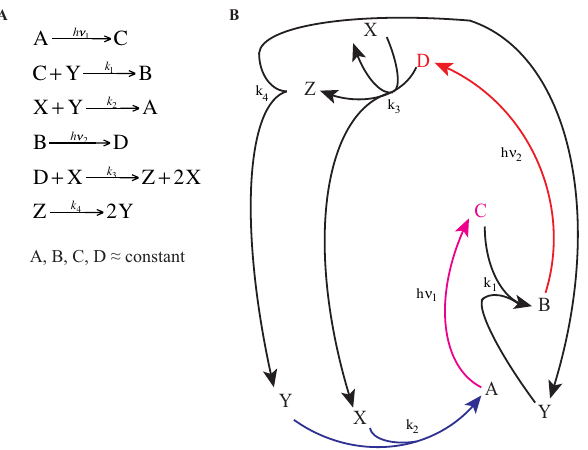
Figure 2. The Coimbrator . Representation of the reactions taking place in the closed system, where C is obtained from A by electronic excitation with hν 1 , and D is obtained from B by electronic excitation with hν 2 . The photochemical steps are shown in red and raise the free energy of the system. Under conditions where A, B, C and D are approximately constant, the changes in the concentrations of the composition variables X , Y , and Z are determined by the reactions C